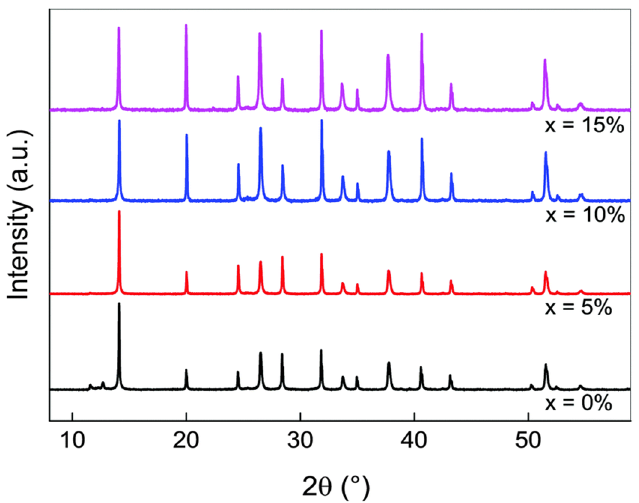
Figure 4. XRD characterization of Cs x M compounds. XRD spectra of perovskite with addition of Cs Cs x (MA 0.17 FA 0.83 ) (1 − x) Pb(I 0.83 Br 0.17 ) 3 , abbreviated as Cs x M, where M stands for “mixed perovskite”. Cs x M with x = 0, 5, 10, 15%. Reproduced with permission from Ref. [67]. Copyright 2016 Energy and Environmental Science.